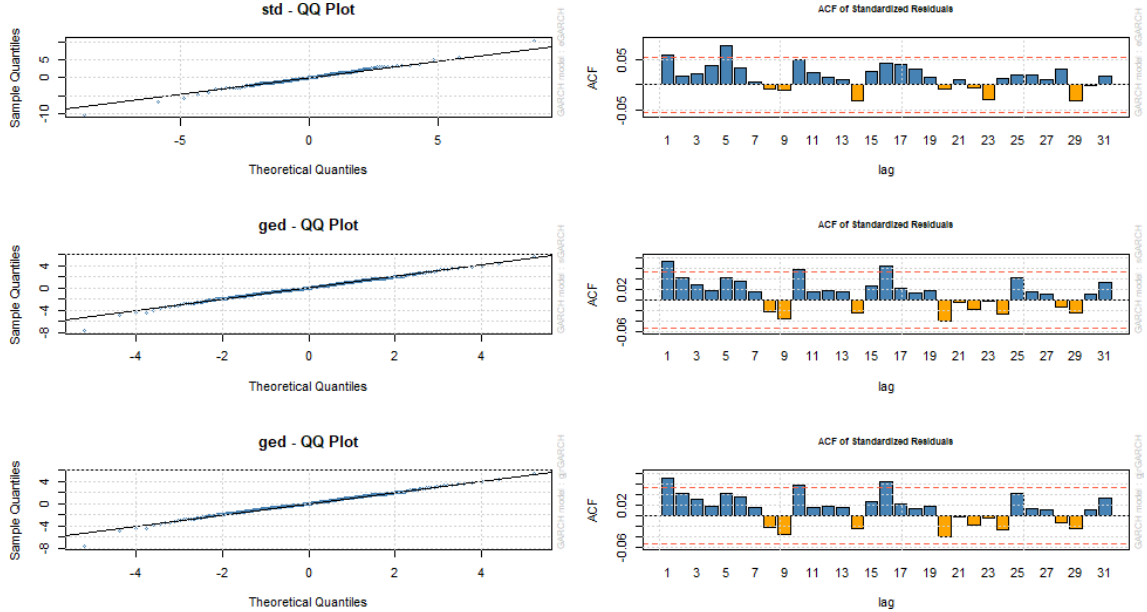
Figure 4. QQ plots and ACF plots for the standardized